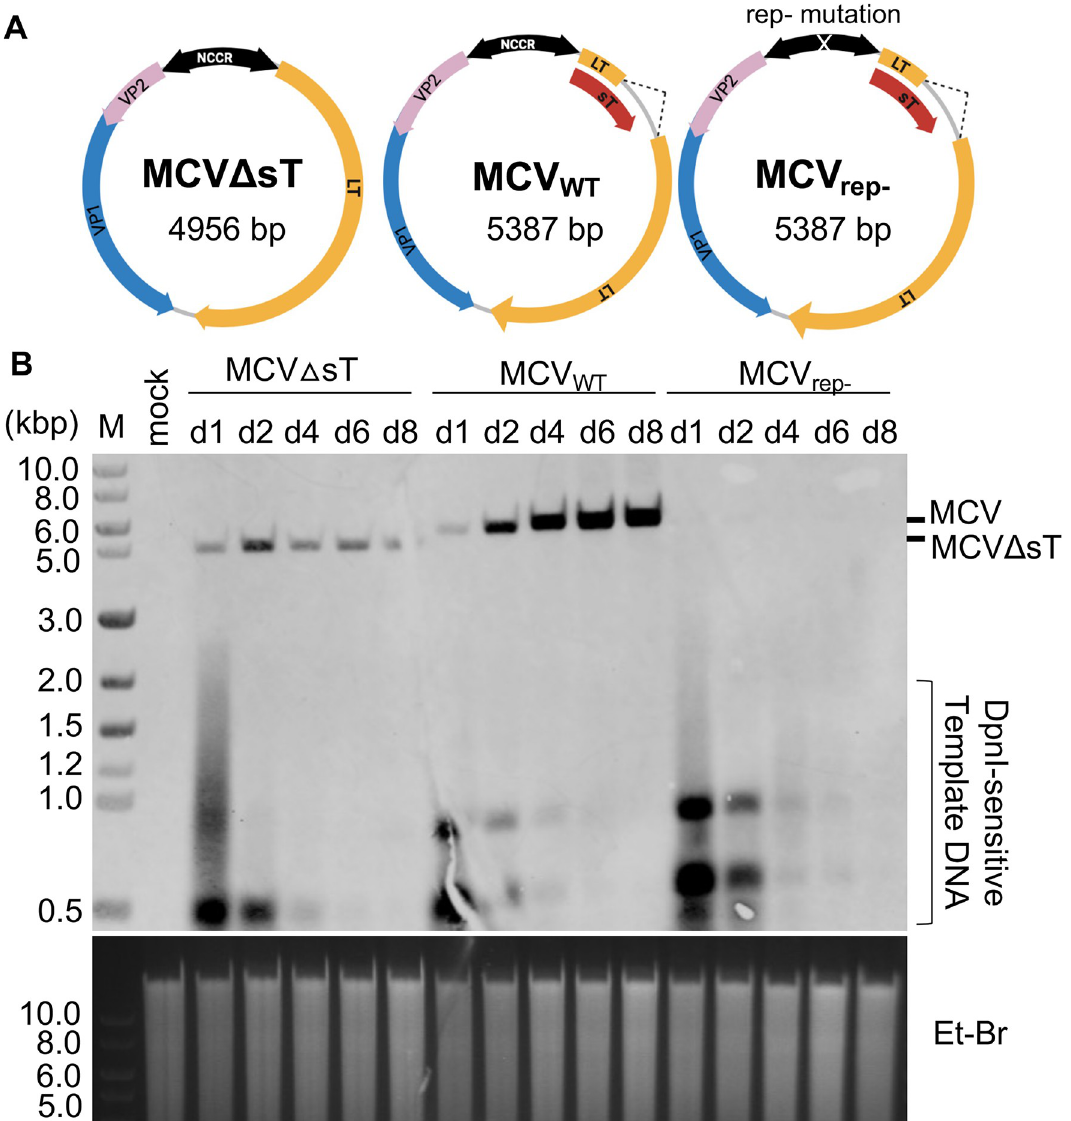
Fig 1. MCV Δ sT cannot maintain its genome in transfected 293 cells. (A) MCV Δ sT with a deletion of sT-specific exon (dotted line in wild type MCV), wild type MCV (MCV WT ), and MCV rep- with an NCCR mutation that ablates LT binding to the origin. (B) 293 cells transfected with MCV WT , MCV Δ sT, and MCV rep- were harvested at various time points up to 8 days p.t. Extracted genomic DNA was digested with EcoRI and DpnI and subjected to Southern blot with an MCV probe. Ethidium bromide (Et-Br) staining was used as a loading control (bottom image). M denotes DNA size